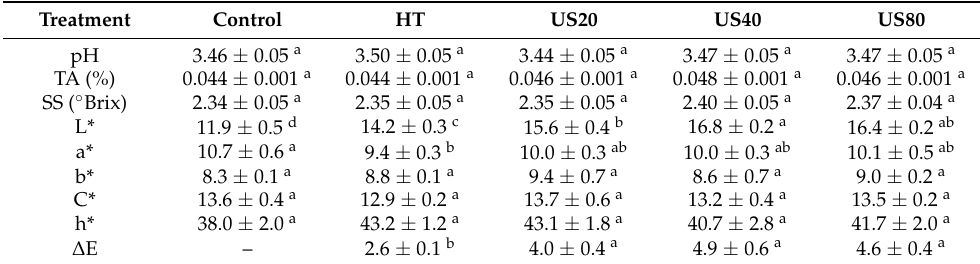
Table 2. Physical chemical characterization of juices.